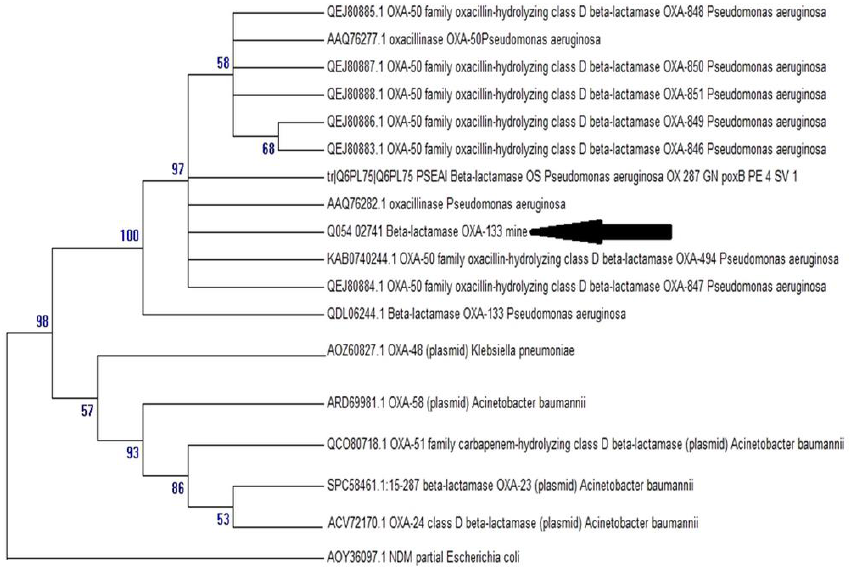
Figure 2. Phylogenetic tree including our sequence, variants of OXA-50 and representatives of the main groups of oxacil- linases.